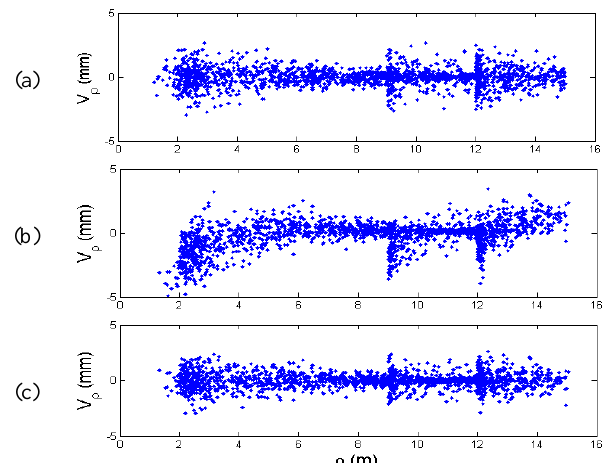
Figure 2: (a) Range residuals versus range plot in plane-based self-calibration for panoramic scanners without systematic errors. (b) Unmodelled 5 mm rangefinder offset. (c) After plane-based